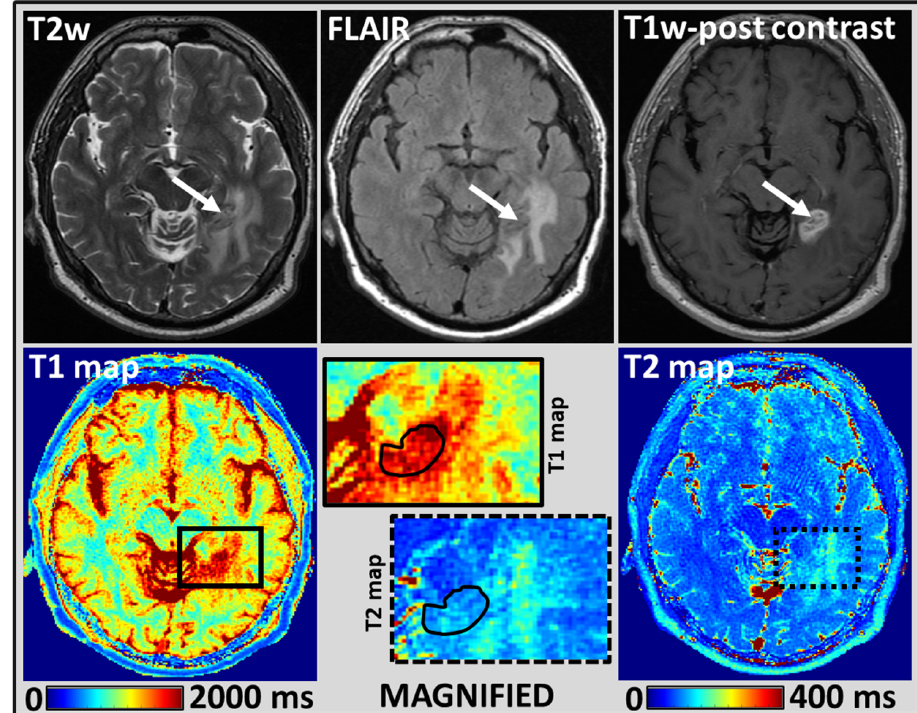
Figure 3. Representative images from a 59-year-old female patient treated with focal RT and had a history of primary lung cancer: T2w (arrow pointing to the lesion), T2w FLAIR, and T1w post-con- trast images from the clinical scan, which demonstrate a left temporal lobe enhancing metastasis ( top row ). A black solid and dotted rectangle region on T1 and T2 maps, respectively, were magni- fied, and the placement of a manually drawn ROI for the BM lesion was shown in a solid black line. MRF-derived quantitative T1 and T2 maps ( bottom row ). The T1 and T2 values from the treated BM lesion were 1906 ms and 106 ms, respectively.